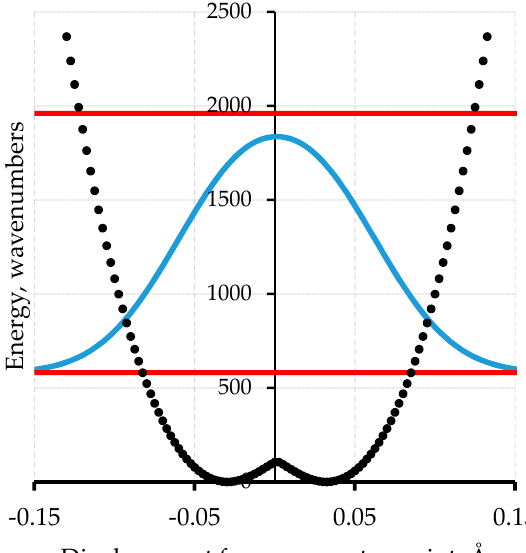
Figure 4. Computed potential energy of polyacetylene using periodic boundary conditions-density functional theory (PBC-DFT) with B3LYP 6-311G(2d,2p) at 240 points (black points) along one displacement direction with subsequent generation of the symmetric potential shown as blue dotted trace [19]. The horizontal red lines are the two lowest energy levels; the light blue line is the probability distribution.